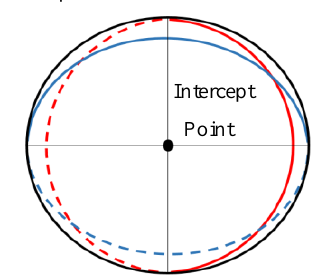
Figure 4 Rotation of the initial cross sectional plane